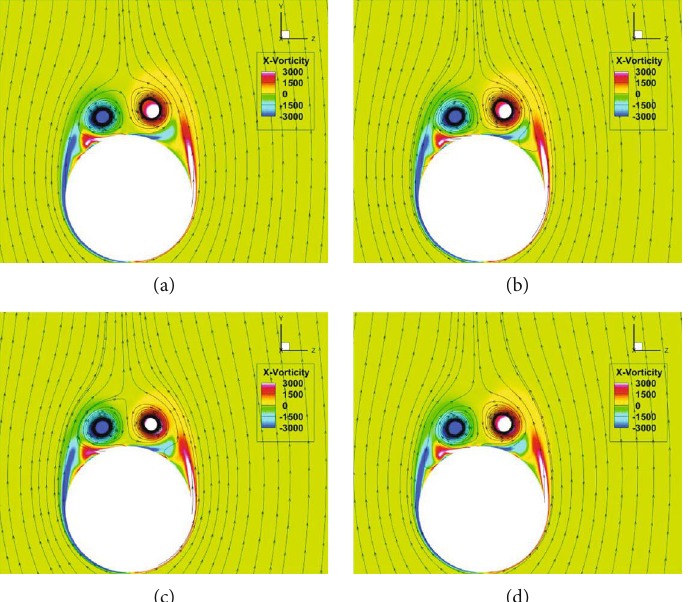
Figure 18: Contrast contour of X -vorticity with di ff erent roughness values at section 1: (a) Model 1, (b) Model 2, (c) Model 3, and (d) Model